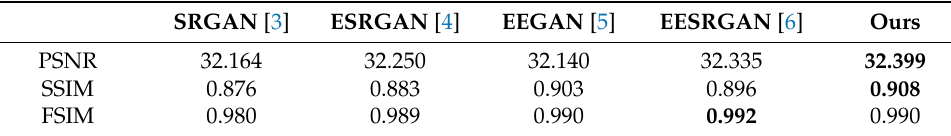
Table 6. SR result performance comparison in the AID dataset, where the best results are shown in boldface.